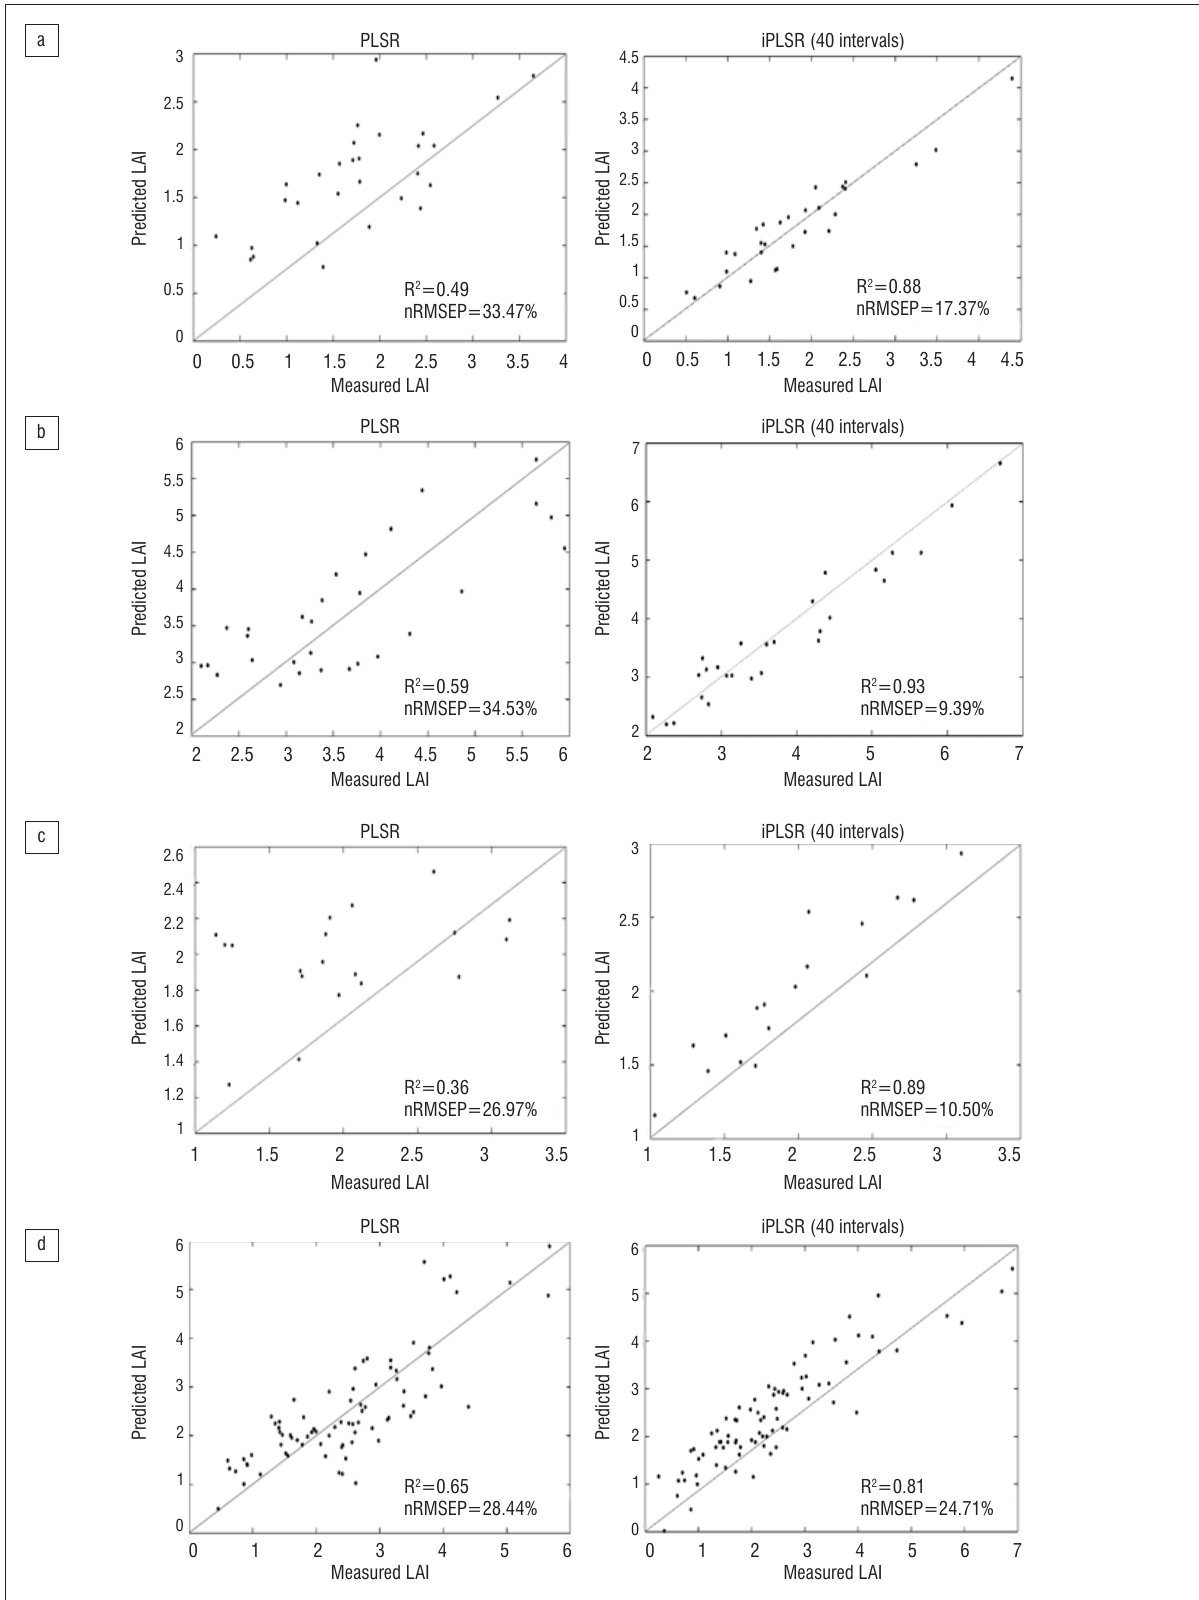
Figure 6: One-to-one relationship (m 2 /m 2 ) between measured and predicted leaf area index (LAI) for validating partial least square regression (PLSR) and interval partial least square regression (iPLSR) models on an independent test data set in (a) early summer, (b) mid-summer, (c) end of summer and for the (d) pooled